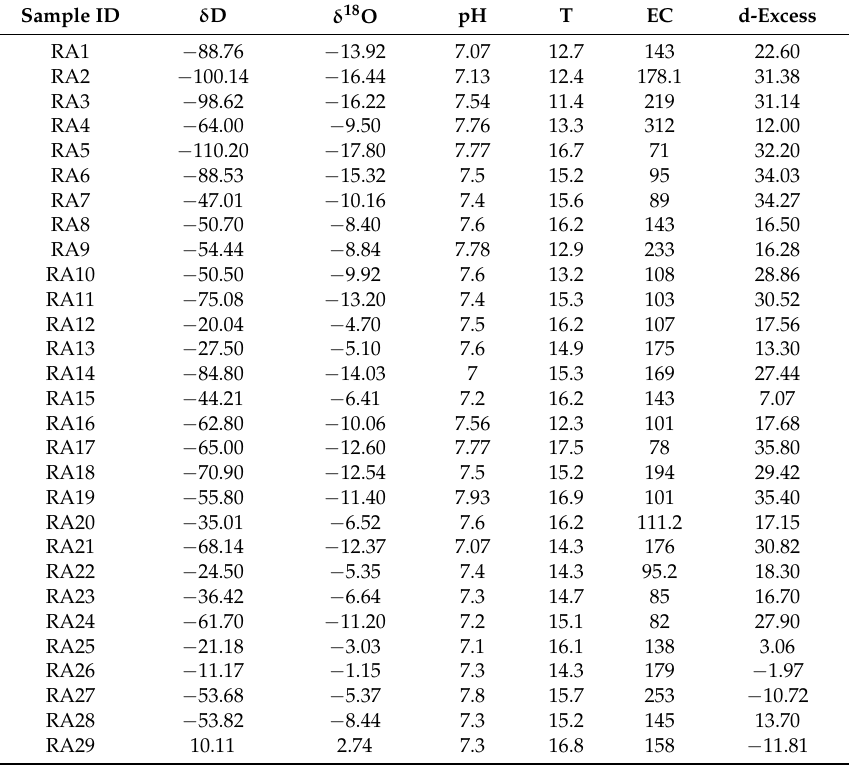
Table 2. Chemical and isotopic compositions of precipitation samples collected in the Zacatecas state (isotopic values are in ‰ , EC ( µ S/cm), T in ◦ C, pH and